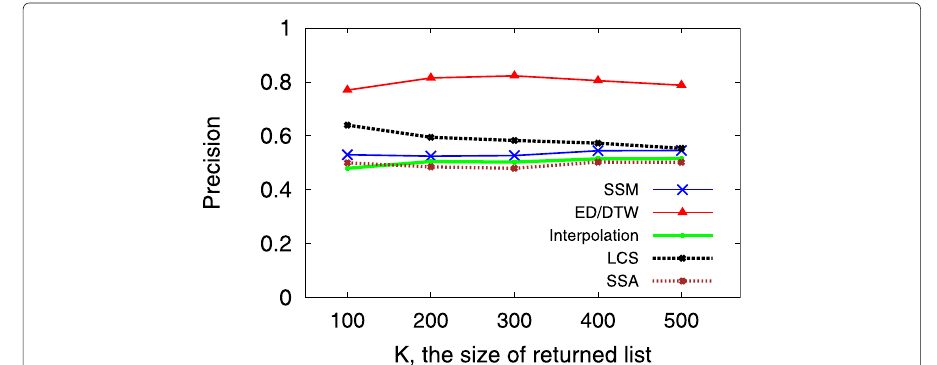
Fig. 12 Precision of outlier detection under different Top-K returned walks